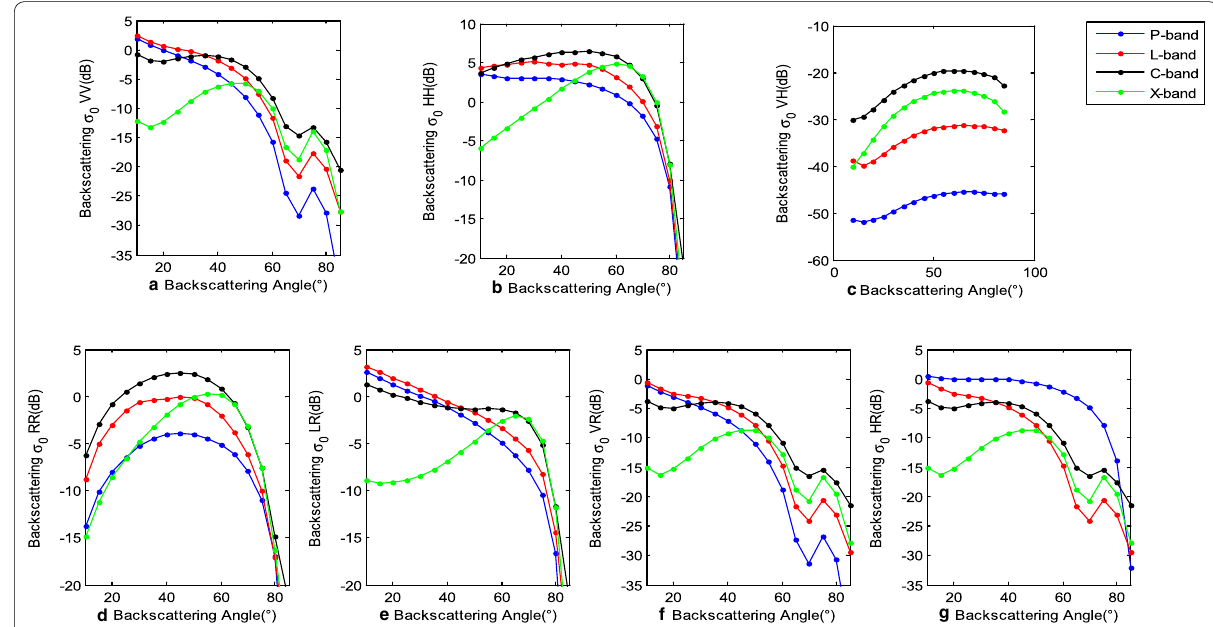
Fig. 9 Canopy scattering cross section versus scattering angle from aspen for L-,C-, and X-bands at backscattering